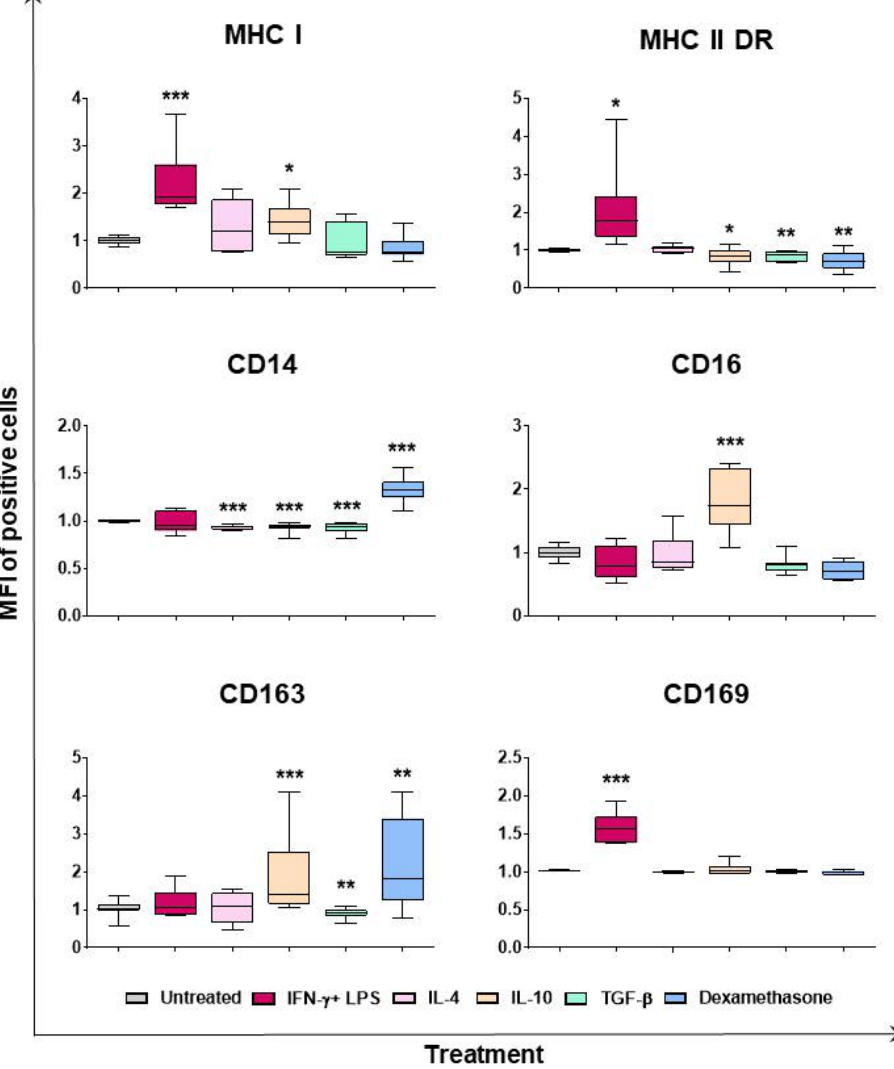
Figure 2. Effect of diverse polarizing factors on porcine moM Φ surface marker expressions (mean of fluorescence intensity). Porcine moM Φ were left untreated, or they were stimulated with diverse polarizing factors: IFN- γ + LPS (both at 100 ng/mL), IL-4 (20 ng/mL), IL-10 (20 ng/mL), TGF- β (20 ng/mL), or dexamethasone (20 ng/mL). Then, 24 h post-stimulation, flow cytometry was employed to determine the expression of several surface markers: MHC I, MHC II DR, CD14, CD16, CD163, and CD169. Mean fluorescence intensity (MFI) of positive cells was evaluated, and MFI data are expressed as fold change relative to the un-activated condition (moM Φ ). Data from three independent experiments utilizing different blood donors are presented. Data are displayed as box-and-whisker plots, showing the median and interquartile range (boxes) and minimum and maximum values (whiskers). Values of treated macrophages were compared to the untreated control (moM Φ ), using an unpaired t -test of a Mann–Whitney test. *** p < 0.001, ** p < 0.01, and * p <